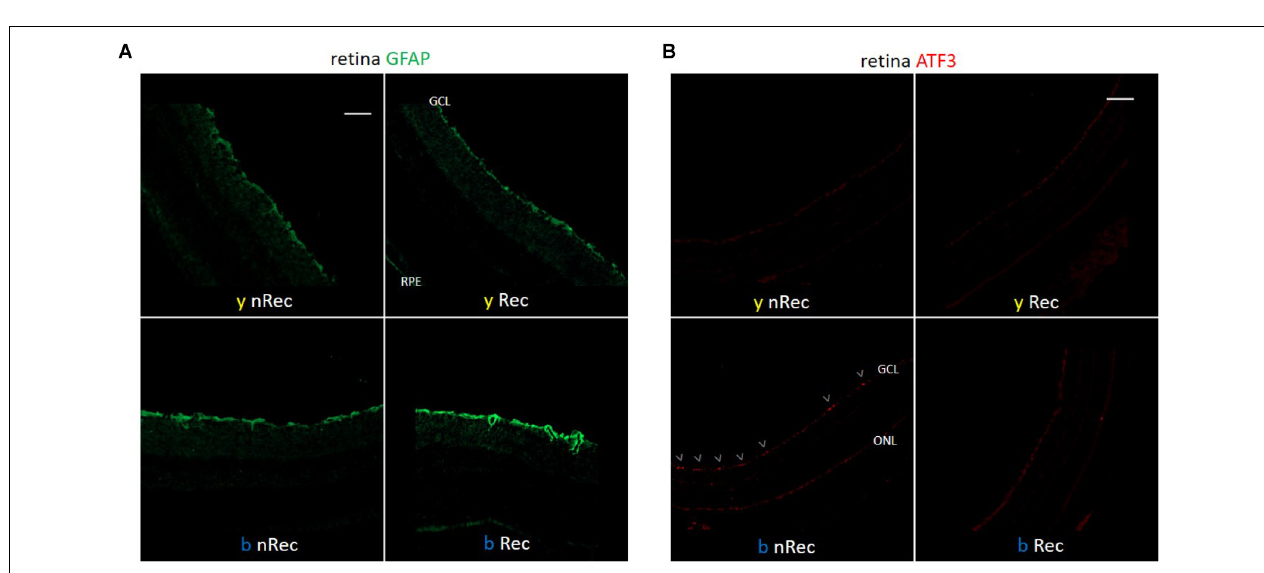
FIGURE 3 | IVCM results. Representative images of non-invasive IVCM examination performed directly after exposure to light ( A , no recovery ) or after 3 days of recovery in standard illumination conditions of animal unit ( B , recovery ). Alterations were observed in the three following corneal layers: superficial epithelium (cell nuclei in blue-illuminated mice became more hyperreflective), sub-basal plexus (dendritic cells are marked by circles) and stroma (activated keratocytes are marked by arrows).